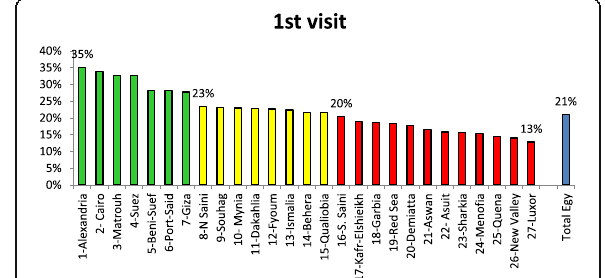
Fig. 2 Rank order of MOHP-FP clinics at governorate level according to the percent of clients ’ reported first visit to FP clinics